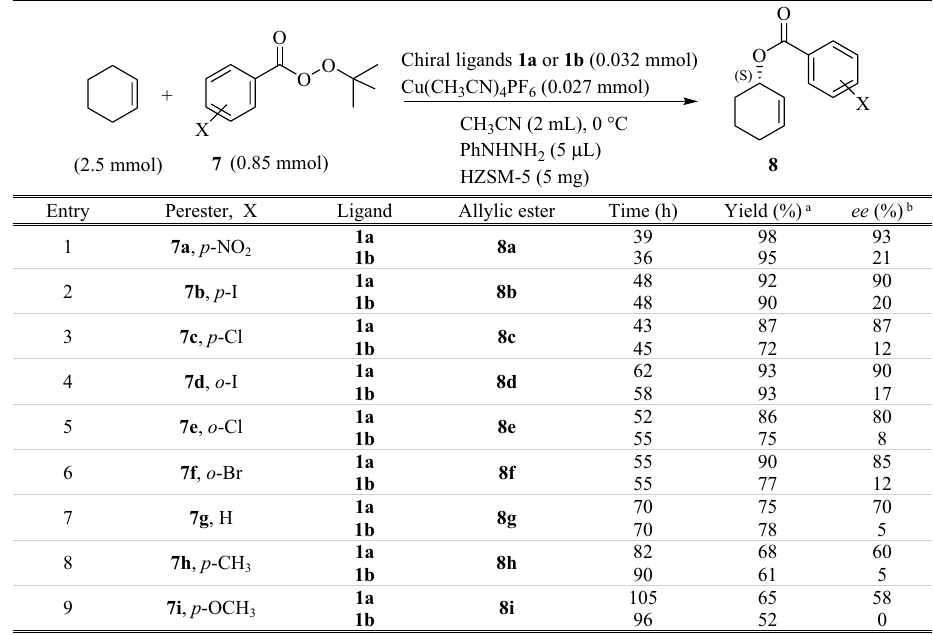
a Isolated yield based on perester.; b Enantiomeric excess was determined by HPLC on Chiralpak AD and/or Chiralcel OD-H columns and/or Nucleocel Alpha Table 1. Effect of stereochemistry of the BOX ligand and substitution on the perester on asymmetric allylic oxidation of cyclohexene.